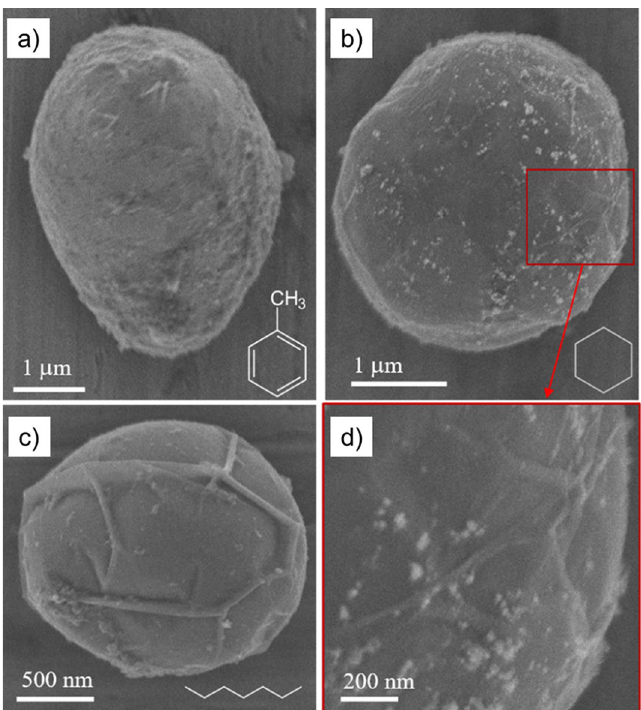
Figure 1. SEM images of typical microparticles collected on the SS substrates and synthesized by discharges sustained in ( a ) toluene, ( b ) cyclohexane, and ( c ) heptane. ( d ) Shows a magnification of the surface feature of ( b ) showing